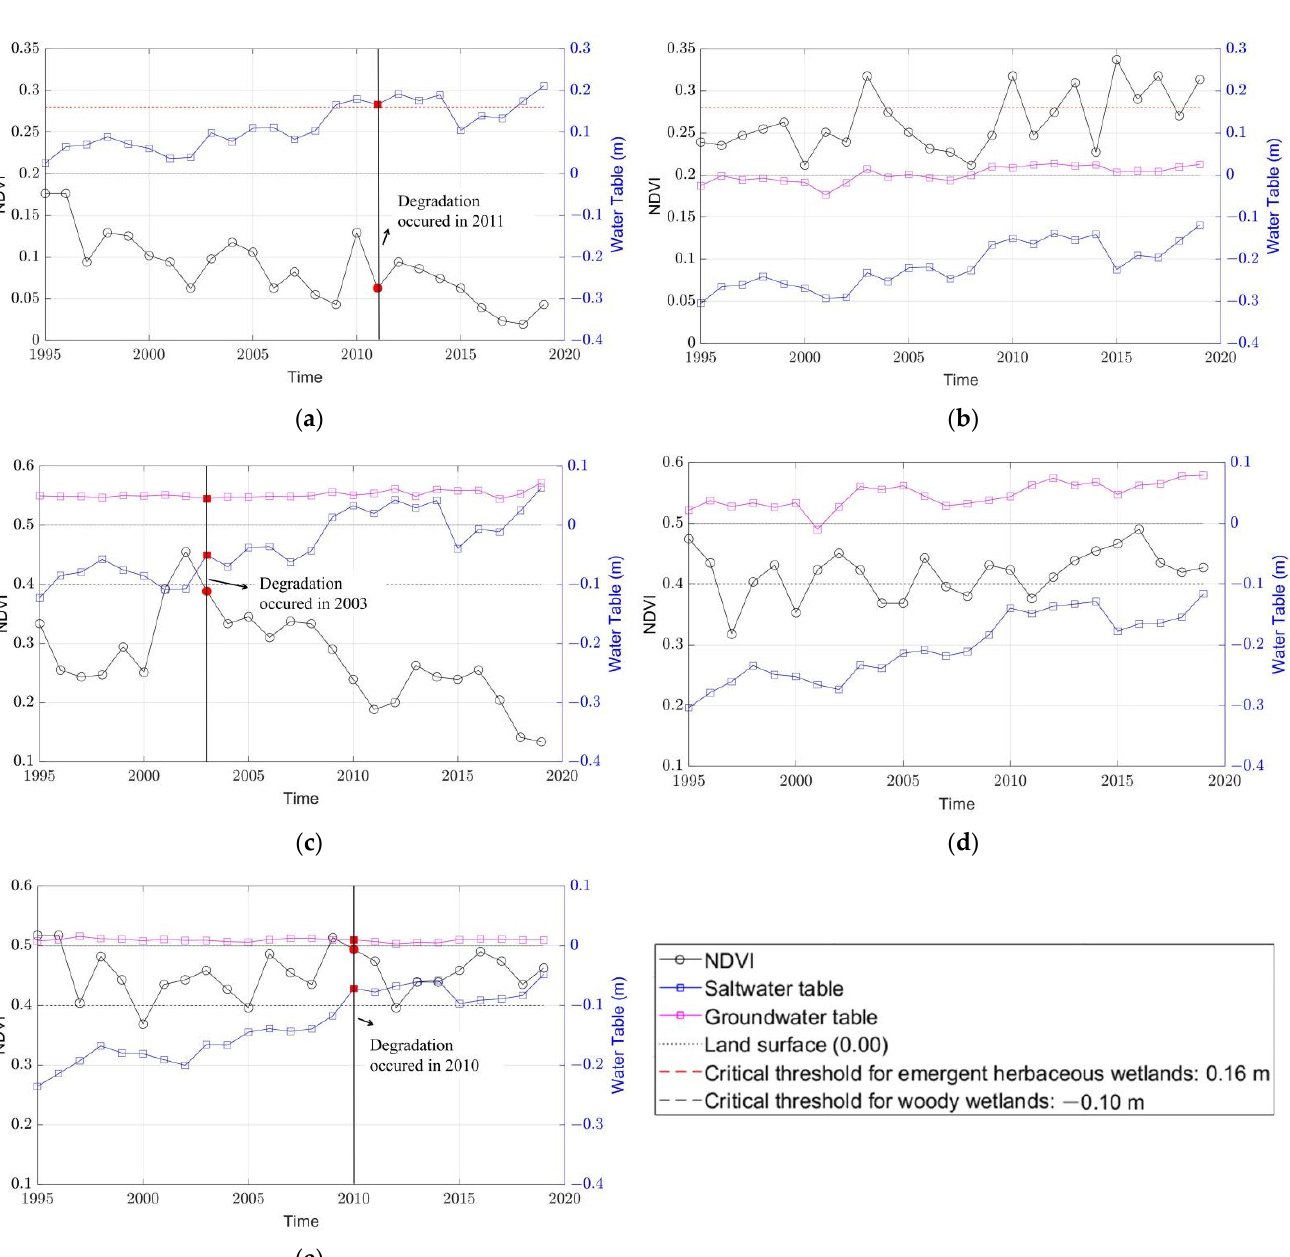
Figure 10. Evolution of the grid-wise mean annual maximum NDVI (left), summer GWTs (right, unit: m), and SWTs (right, unit: m) for ( a ) Type 6 degradation (emergent herbaceous wetlands degrading to non-vegetated areas). Summer mean GWTs are not presented for the same reason in Figure 9a; ( b ) Emergent herbaceous wetlands without degradation; ( c ) Type 5 degradation (transitional forested wetlands degrading to emergent herbaceous wetlands); ( d ) Transitional forested wetlands without degradation; ( e ) Type 3 degradation (forested wetlands degrading to transitional forested wetlands). Red and black horizontal dash lines represent the critical thresholds for emergent herbaceous wetlands (0.16 m) and woody wetlands ( − 0.10 m), respectively. Solid dots in red highlight NDVI, SWTs, and GWTs of degraded wetlands in the year degradation occurred.